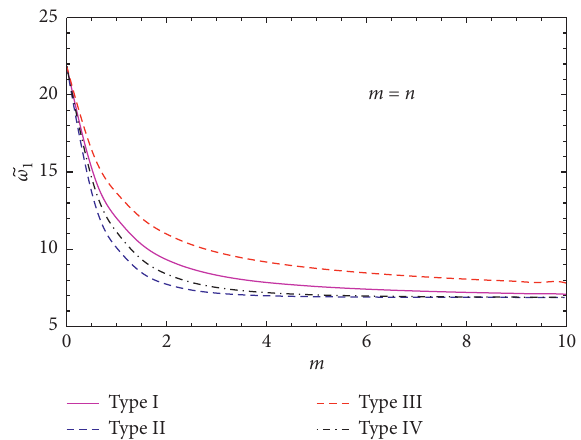
Figure 2: Variation of the dimensionless fundamental frequency of BDFG beam versus the functional gradient parameters with L / h � 20, P � 5, and P � s d